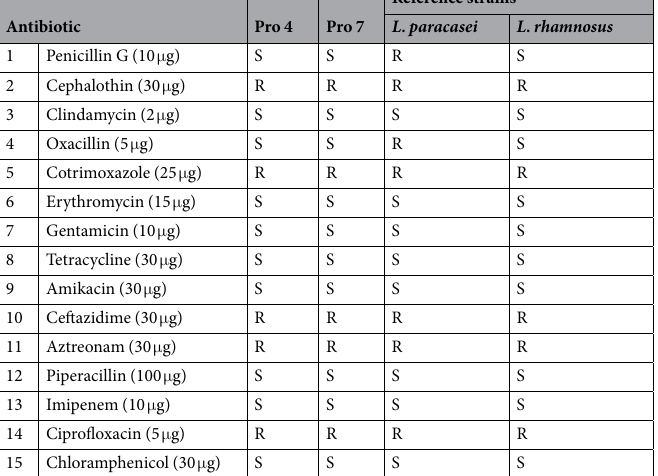
Table 3. Antibiotic susceptibility of selected probiotic strains. Notes: R = resistant, S =